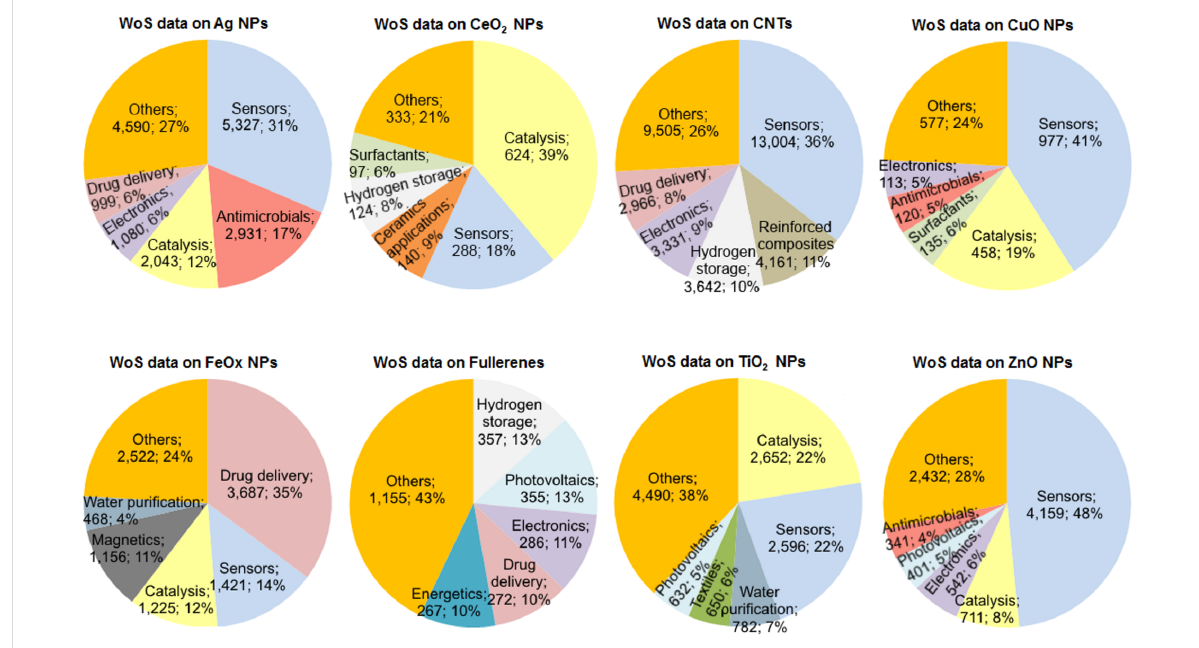
Figure 1: Proposed fields of application of engineered nanomaterials (ENMs) according to the publications in Thomson Reuters WoS. Keywords were selected from the review by Bondarenko et al. [4]. Numbers below each application category indicate the number and share of papers retrieved. The numerical data are presented in Table S1 (Supporting Information File 1). The bibliometric data search was performed in Thomson Reuters WoS on March 19,